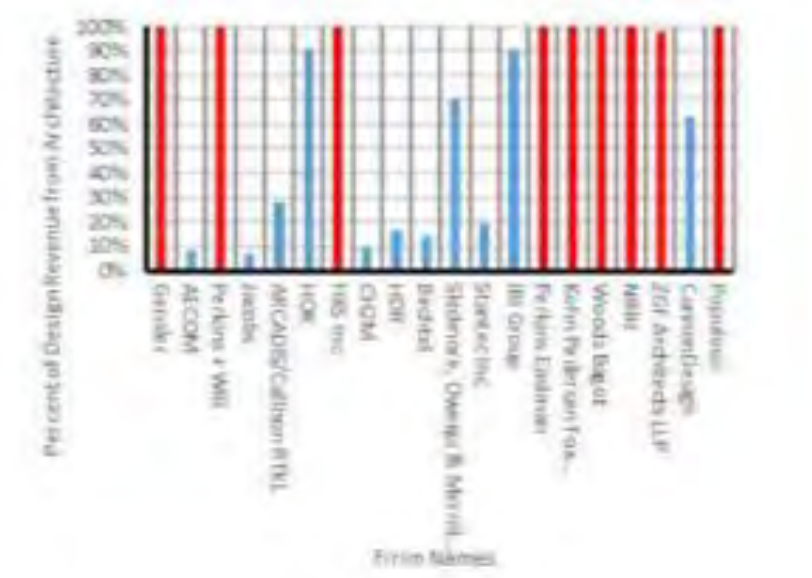
Figure 6. Percent of Design Revenue from Architecture